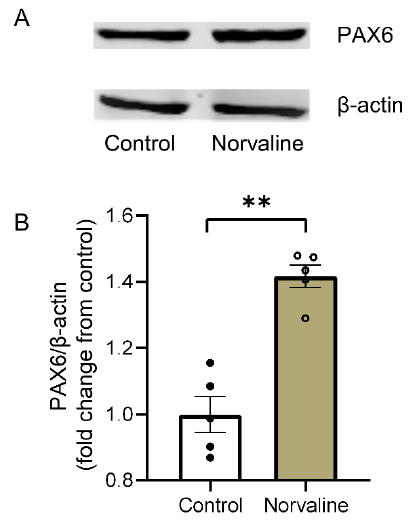
Figure 5. Western blot analysis of the hippocampal lysates using anti-PAX6, and anti-β-actin antibodies ( A ). The normalized data ( B ) are presented as the mean ± SEM ( n = 5 brains per group). ** p < 0.01 (two-tailed Student’s t -test).